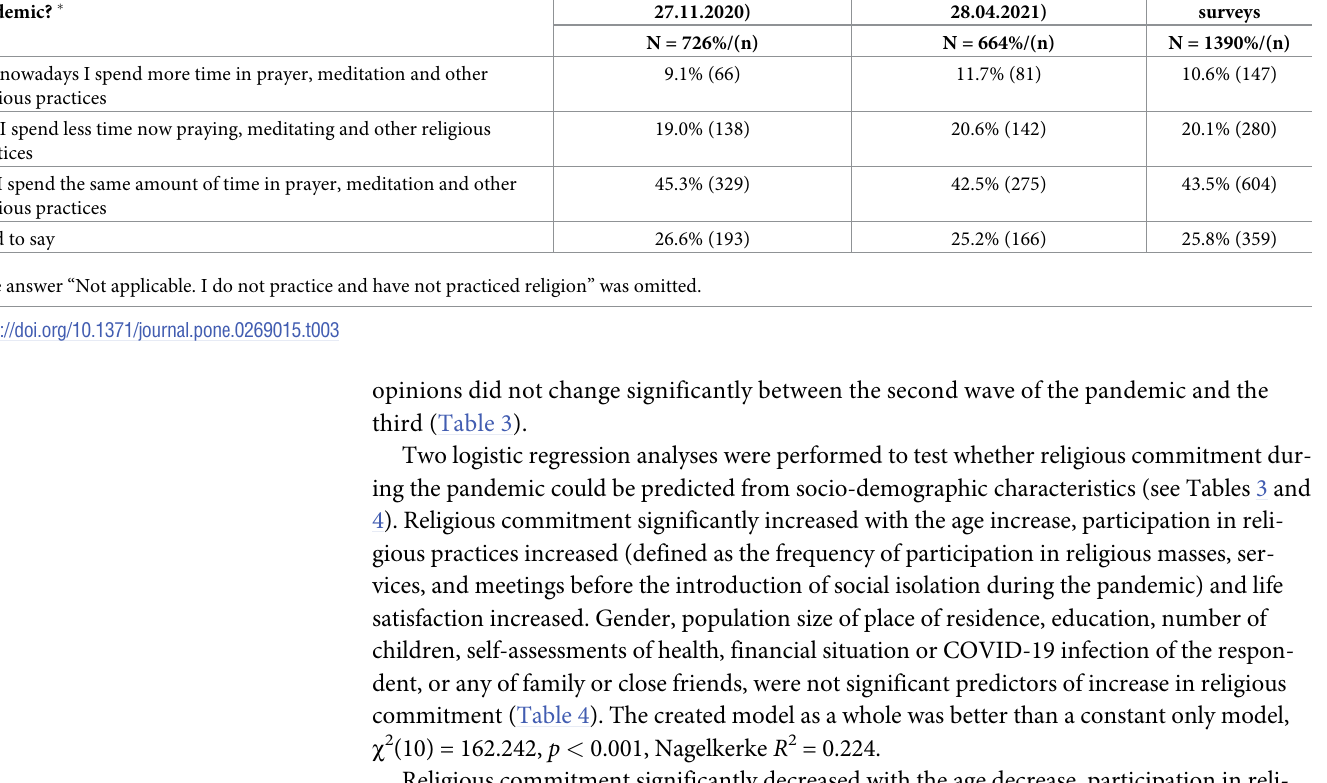
Table 3. Religious commitment during the pandemic.